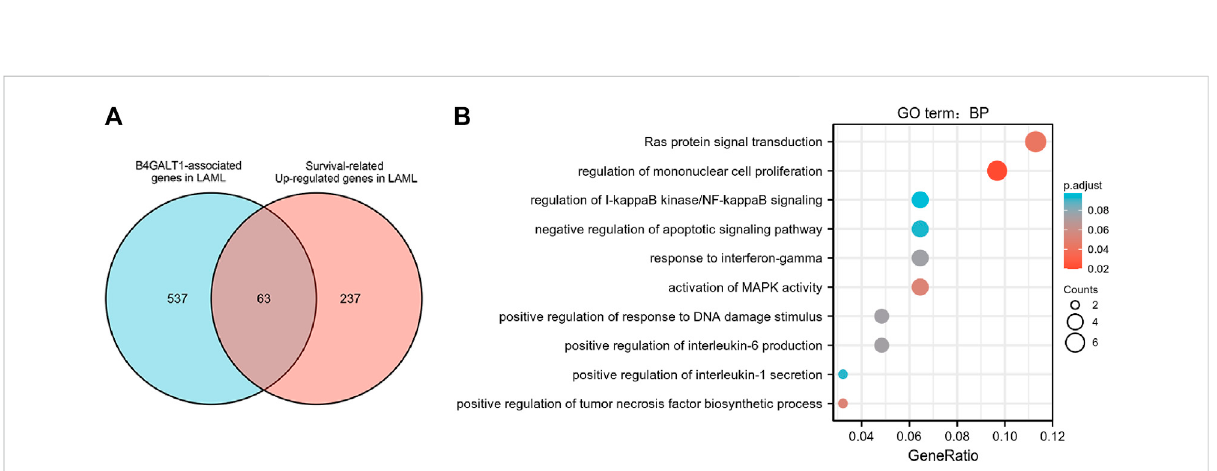
FIGURE 6 Functional clustering analysis of B4GALT1-related genes. (A) Venn diagram of B4GALT1-related genes and survival-related upregulated genes in LAML. (B) GO enrichment analysis of B4GALT1-related genes and LAML survival-related genes in